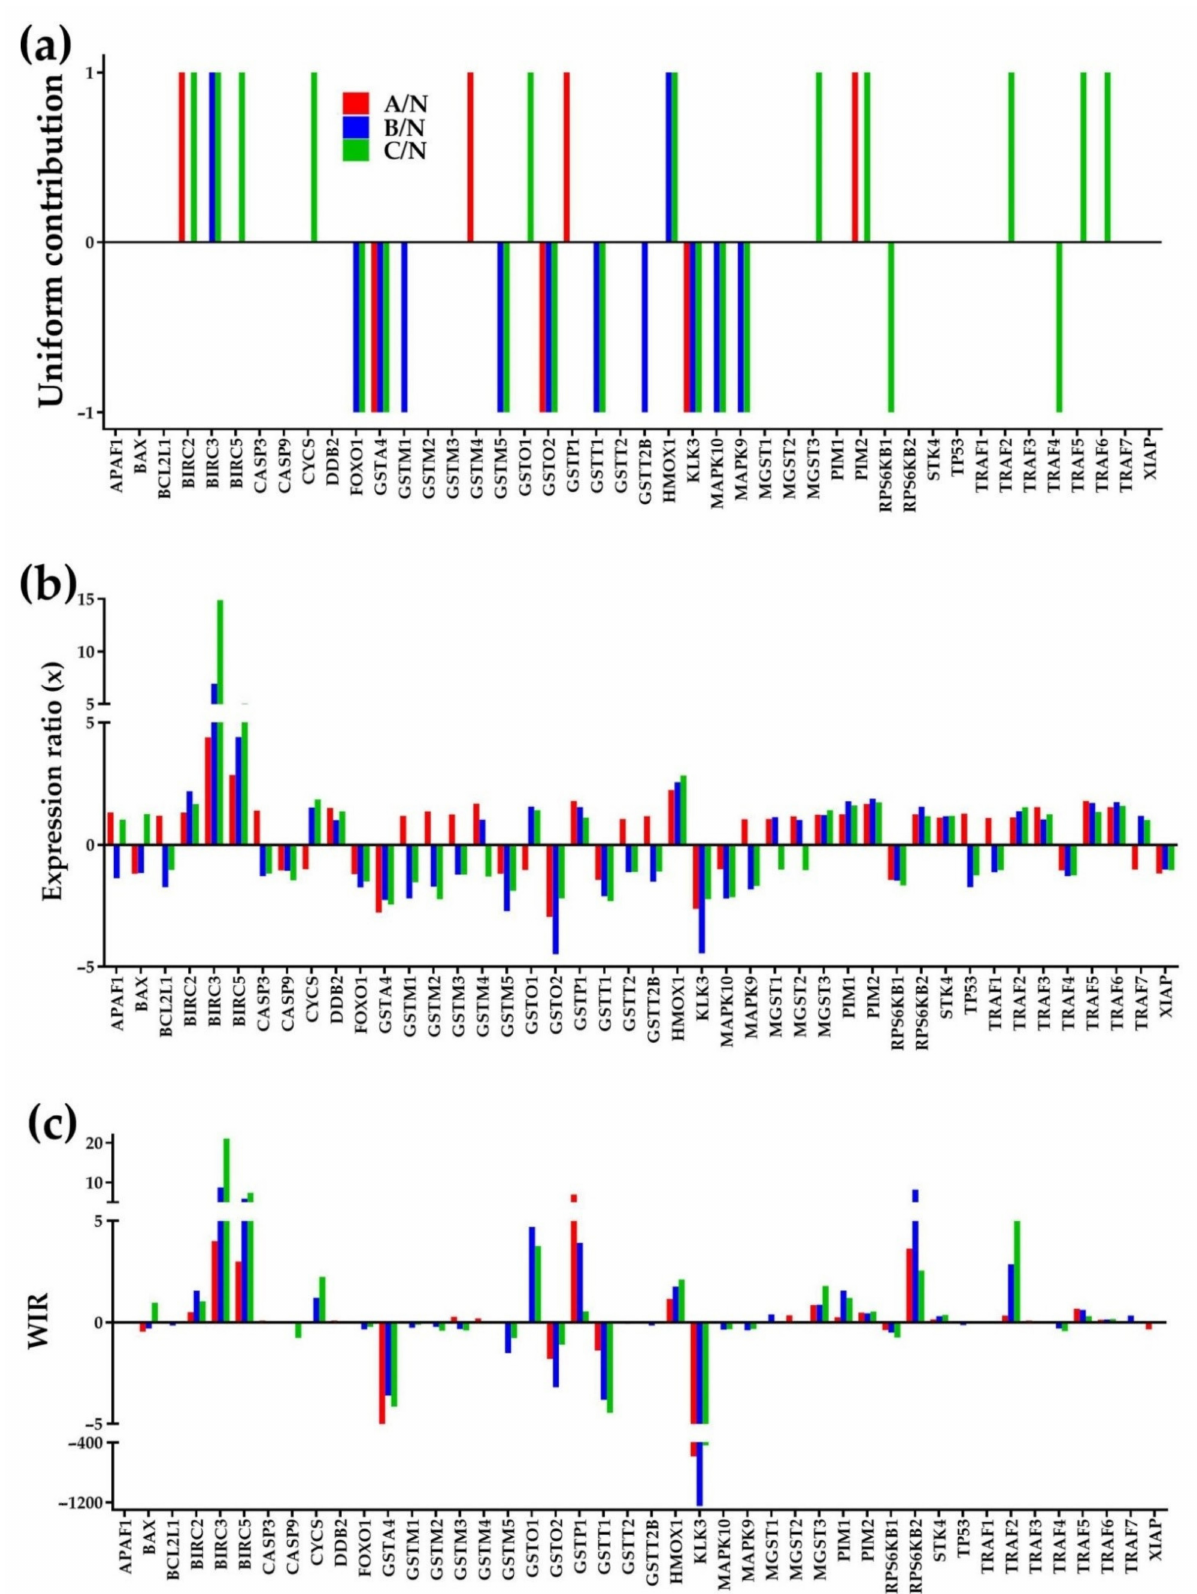
Figure 2. Regulation of 44 evading apoptosis genes in the three cancer nodules (“A”, “B”, “C”) with respect to the normal tissue (N) measured as ( a ) uniform contribution of the significantly regulated genes, ( b ) expression ratio “x” and ( c ) Weighted Individual (gene) Regulation